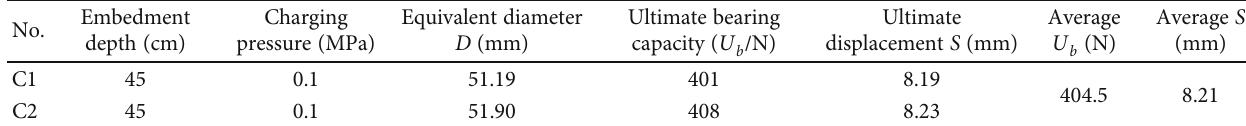
Table 2: Testing data from a single in fl atable anchor.